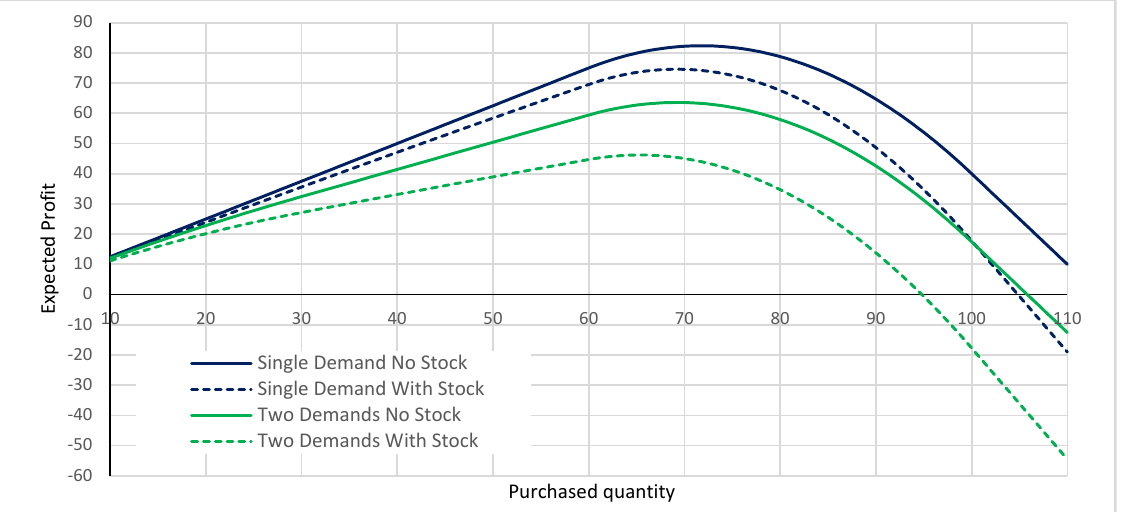
Fig. 3. Comparison of the four different expected